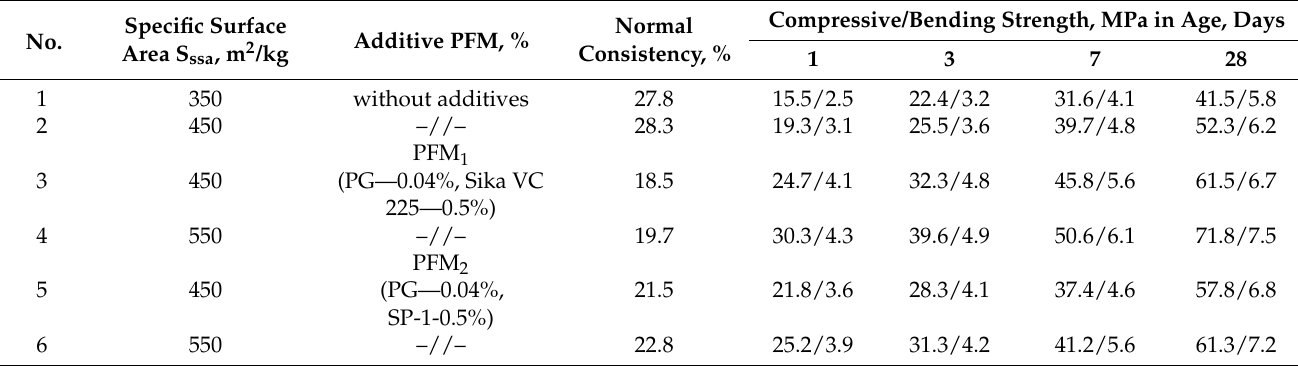
Table 3. The main properties of composite cement